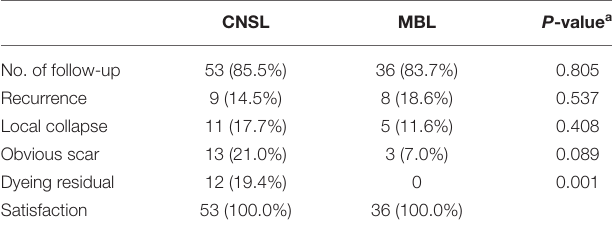
TABLE 4 | Postoperative data during the time of